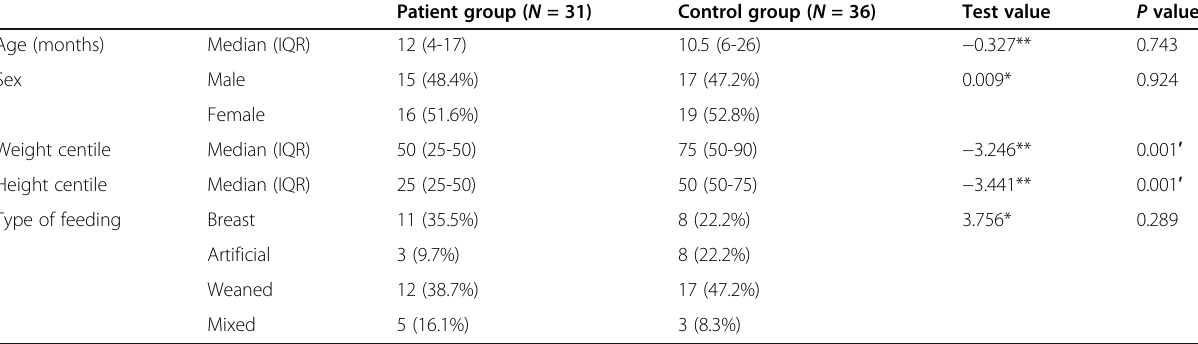
Table 1 Characteristics of the study population